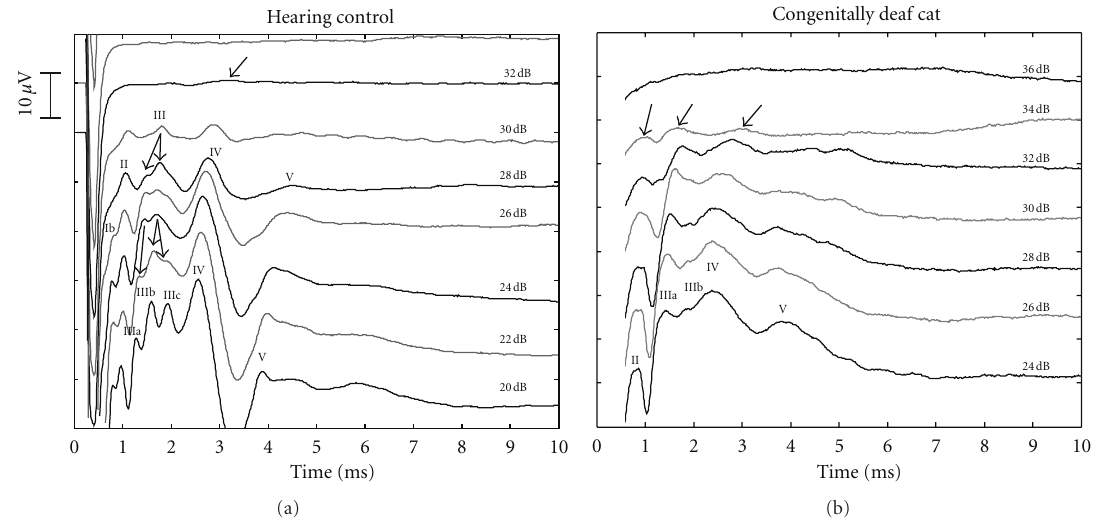
Figure 1: Examples of E-ABRs recorded from an adult hearing control (a) and an adult CDC (b). Arrows point to E-ABR components at threshold intensity. Current levels are given in dB attenuation (re 3 mApp). In general, similar morphology was observed, with some less-well di ff erentiated waves in CDCs. Stimulus artifact (starting at 0ms) was removed.